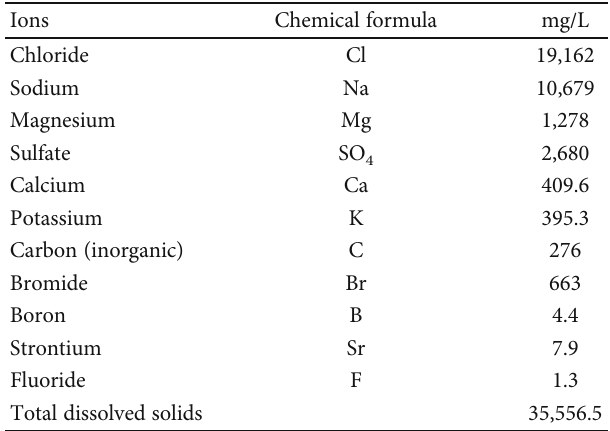
Table 4: Chemical analysis results for the fi eld injected water.